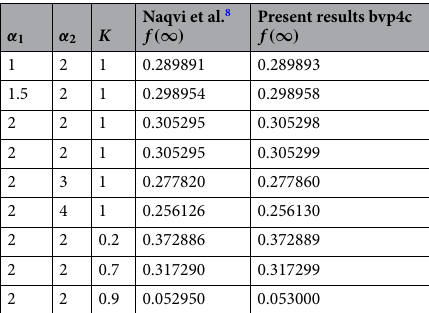
Table 5. The tabulation of numerical results of f (